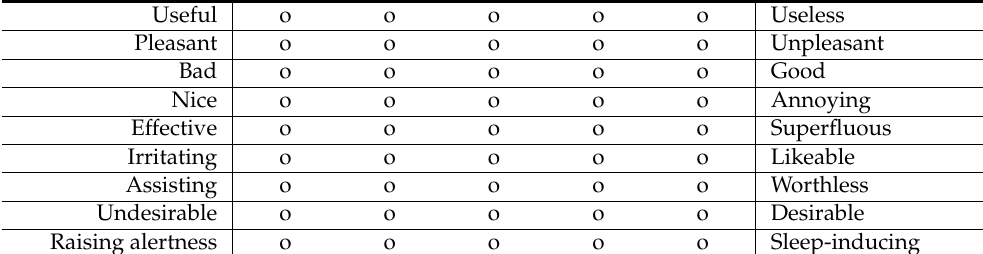
Table 5. System Acceptance Scale